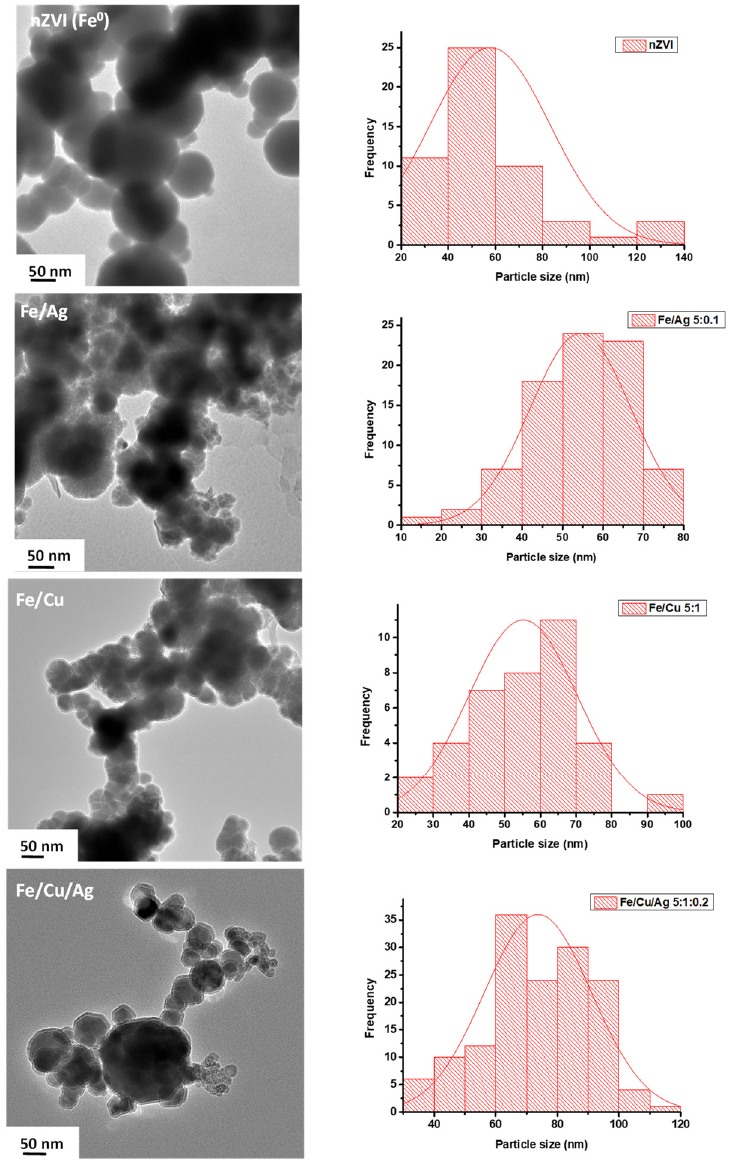
Figure 4. TEM images of nZVI, Fe/Ag 5:0.1, Fe/Cu 5:1, Fe/Cu/Ag 5:1:0.2 and the corresponding particle size histograms.